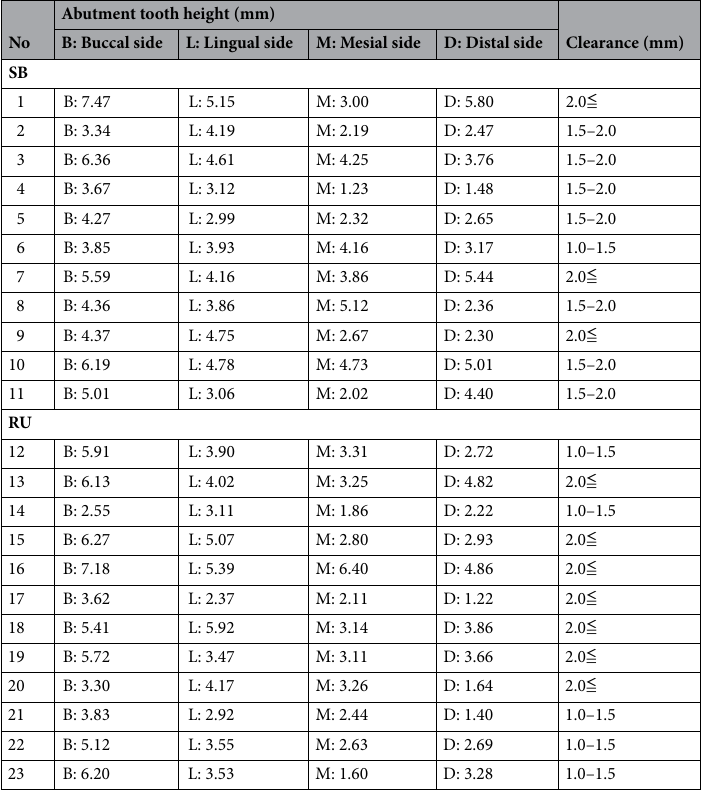
Table 2. Abutment morphology. SB super-bond C&B, RU relyX ultimate resin